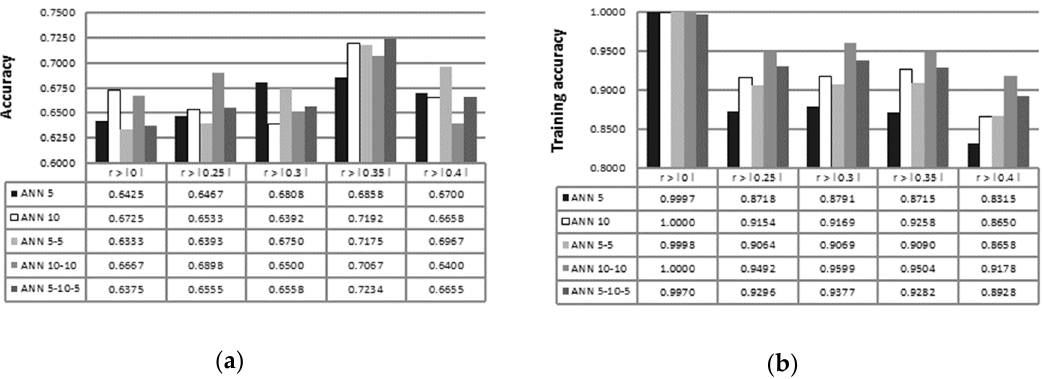
Figure 2. Accuracy ( a ) and training accuracy ( b ) measures of ANN 5, ANN 10, ANN 5-5, ANN 10-10, and ANN 5-10-5 configurations with Pearson’s-based feature selection.